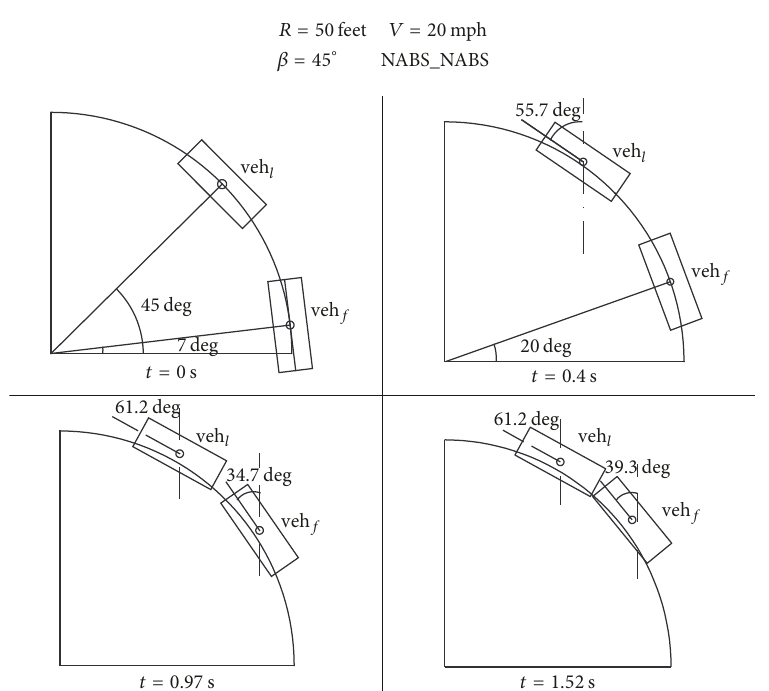
Figure 3: Time-lapse sequence for two left-turning vehicles, with wheels-locked braking trajectories. Parameters: 𝑟 = 50 󸀠 , 𝛽 𝑙 = 45 ∘ , and V = 20